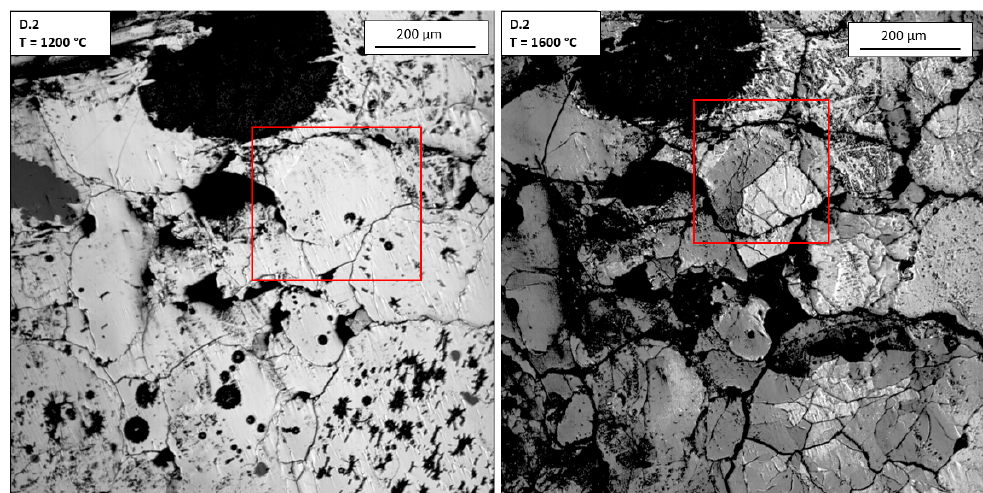
Figure 7. Images from high temperature confocal microscope (HTCM) experiment for A.2 at 300 °C and 600 °C, showing crack formation from cavities from escaped fluid inclusions.